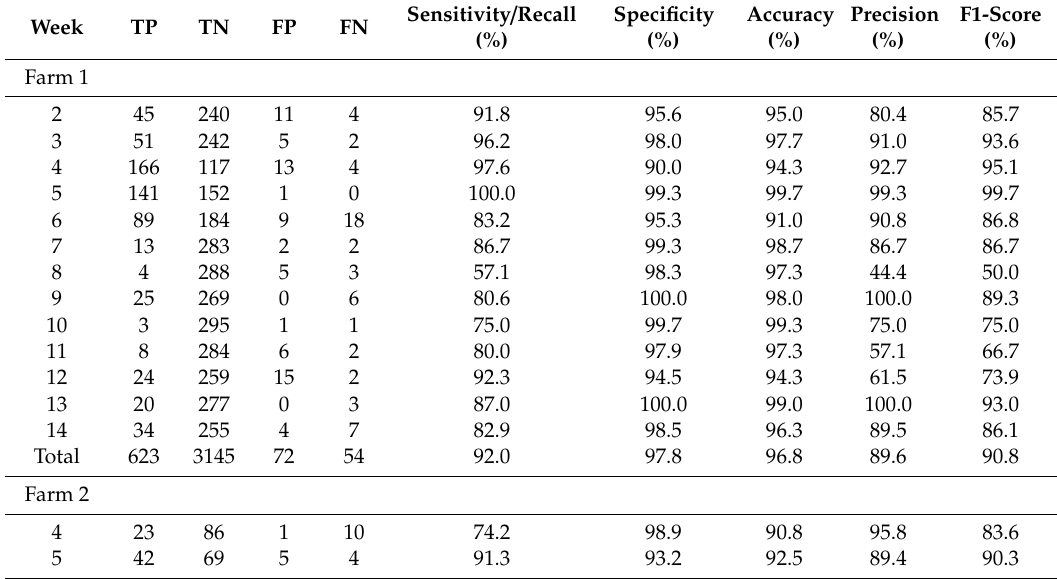
Table 2. Detection success of the convolutional neural network (CNN) model for female turkeys with intact beaks, n = 300 s (farm 1, weeks of life 2–14) and male turkeys with trimmed beaks, n = 120 s (farm 2, week of life 4 and